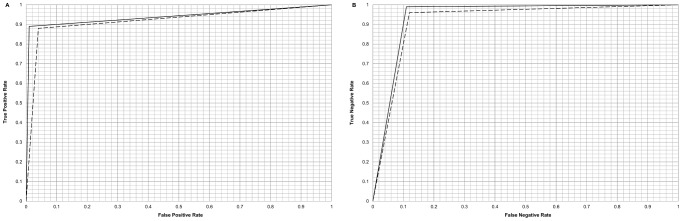
ROC curves for ER+ and ER− classification using linear and RBF kernels.ROC curves and area under ROC curve (AUC) values can be used as more robust measures of classifier accuracy beyond overall classification accuracy. (A) ROC curves for ER+ classification. (B) ROC curves for ER− classification. In both cases the linear model is represented by a dashed line and the RBF kernel model is represented by a solid line. The point on each curve corresponds to the true positive/negative and false positive/negative values obtained from 100 iterations of 10-fold cross-validation carried out on 542 samples with 200 SNP features. The ROC curve for any meaningful classifier needs to lie above the y = x line; the case where equal proportions of cases would be classified correctly and incorrectly, as would occur if class values were assigned at random.